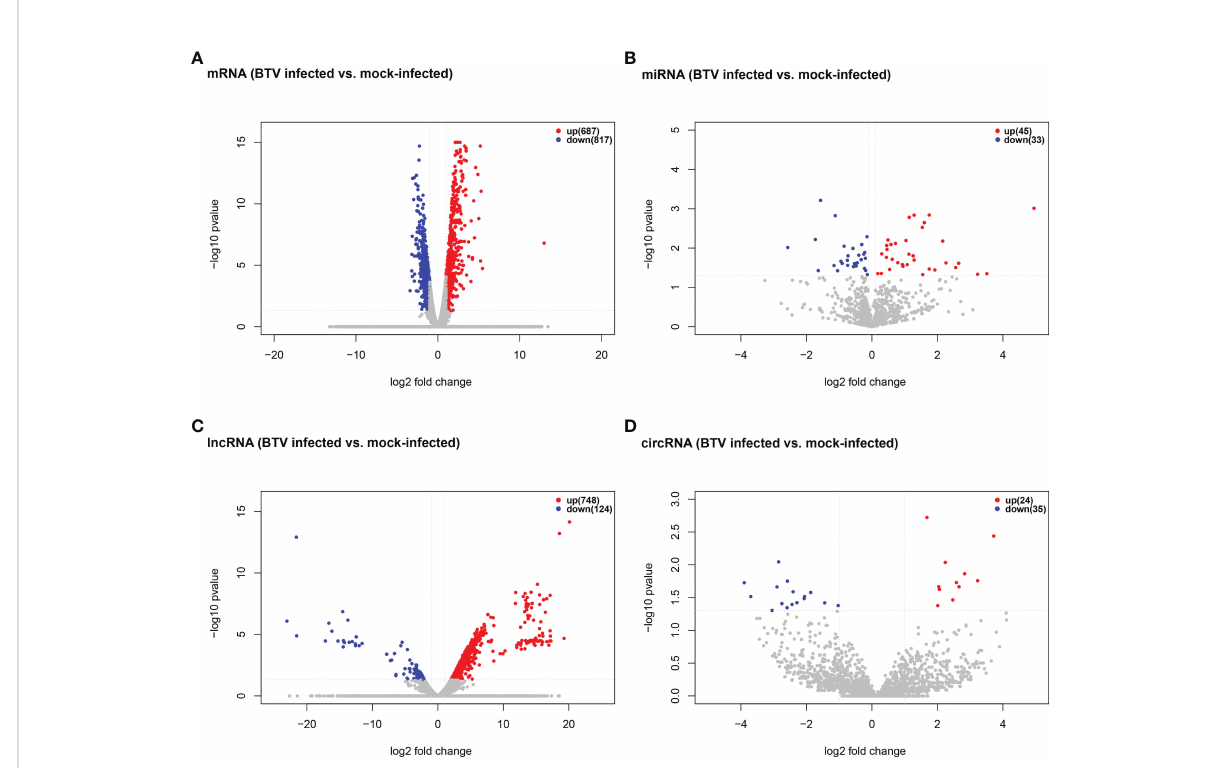
FIGURE 2 Volcano plots of (A) dif-mRNAs, (B) dif-miRNAs, (C) dif-lncRNAs, and (D) dif-circRNAs between BTV-1-infected and mock-infected OA3.Ts cells. Red and blue dots represented upregulated and downregulated dif-RNA, respectively. The total numbers of upregulated and downregulated dif- RNAs were marked in the upper right corner of each fi